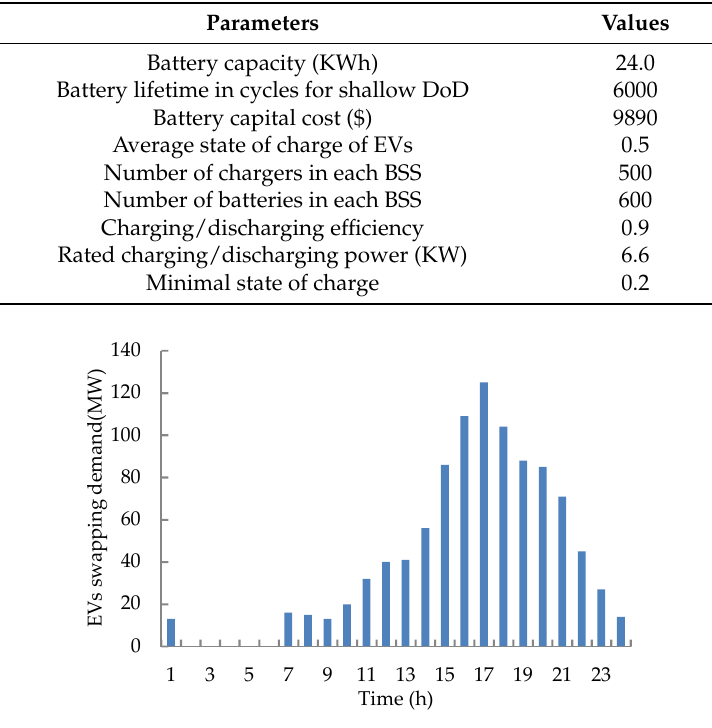
Figure 3. Battery swapping demand of EVs in each BSS.